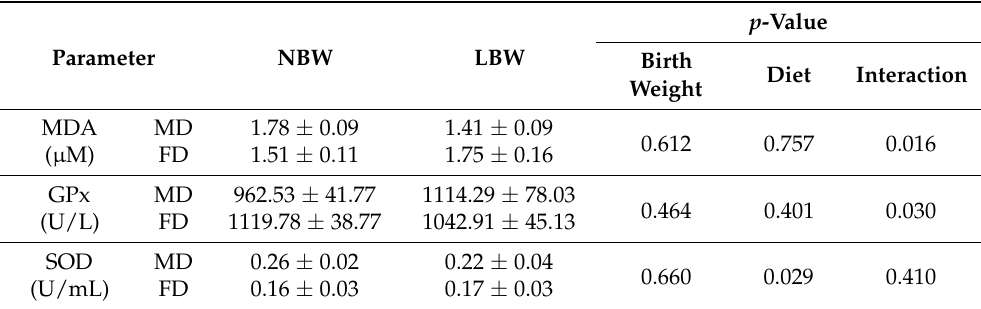
Table 3. Mean ( ± S.E.M.) and p -values of plasma concentrations of parameters for oxidative status, at 385 days-old, in female and male pigs with normal or low birth-weight (NBW and LBW, respectively) and fed with maintenance or fattening diets (MD and FD,